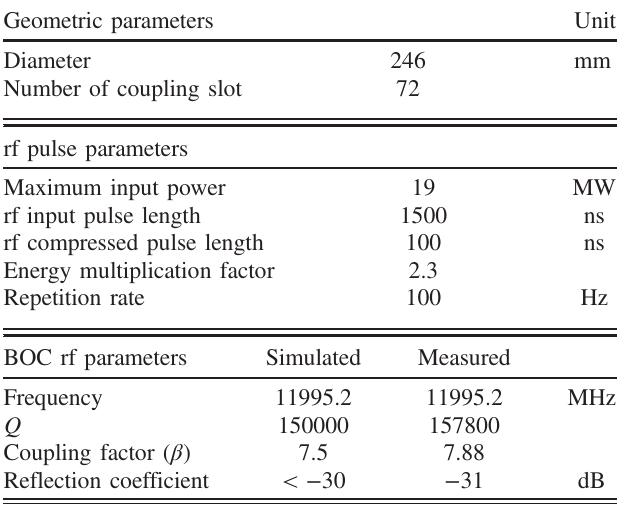
TABLE II. Main rf parameters of the XBOC working with a TM 18 mode. The temperature is 40 °C and 41 . 2 °C for the ; 1 ; 1 simulated and measured resonant frequency, respectively.